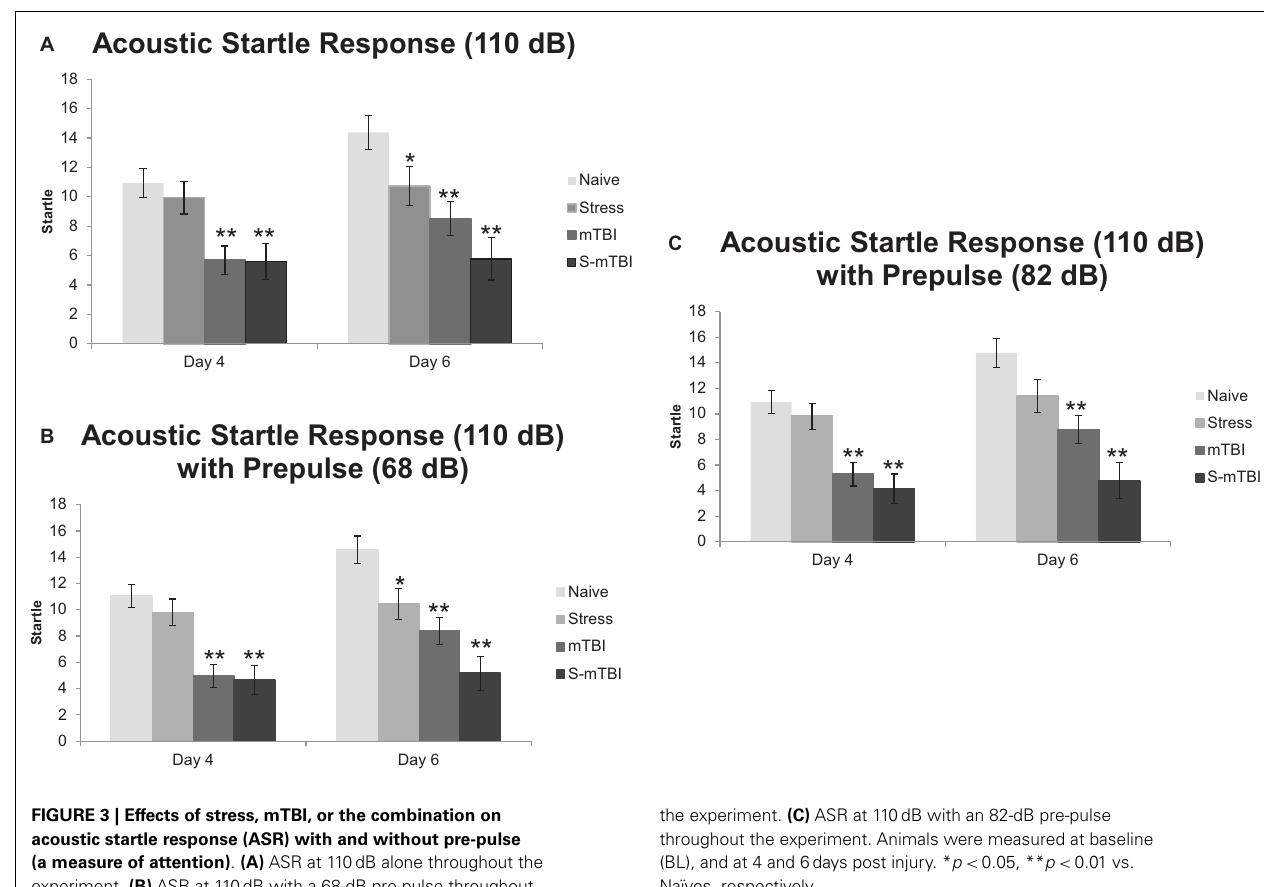
FIGURE 2 | Effects of stress, mTBI, or the combination on neurobehavioral function . Neurobehavioral severity was determined by using a 10-item test with a score of 0, 1, 2, on each given task. Higher scores indicate more neurobehavioral impairment. Animals were tested